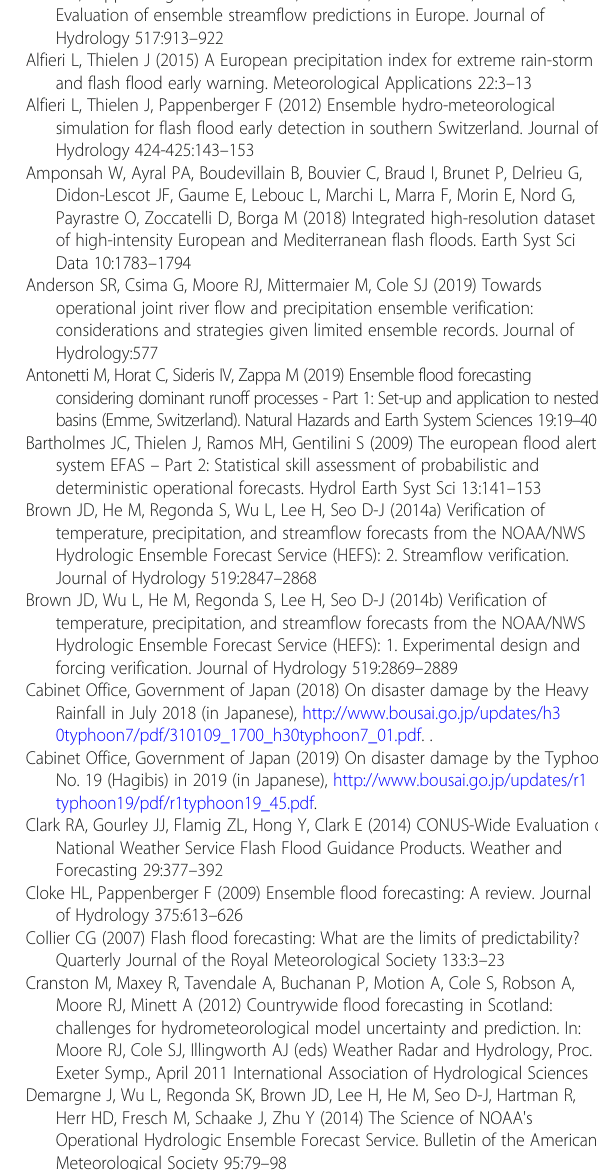
Additional file 1: Figure S1. Observed and simulated/hindcasted hydrographs at dam reservoirs for T19 (uncalibrated case). The “ Radar ” shows the simulated hydrographs, and “ MEPS ” denotes the hindcasted results at 9:00 on October 11, 2019. Additional file 2.